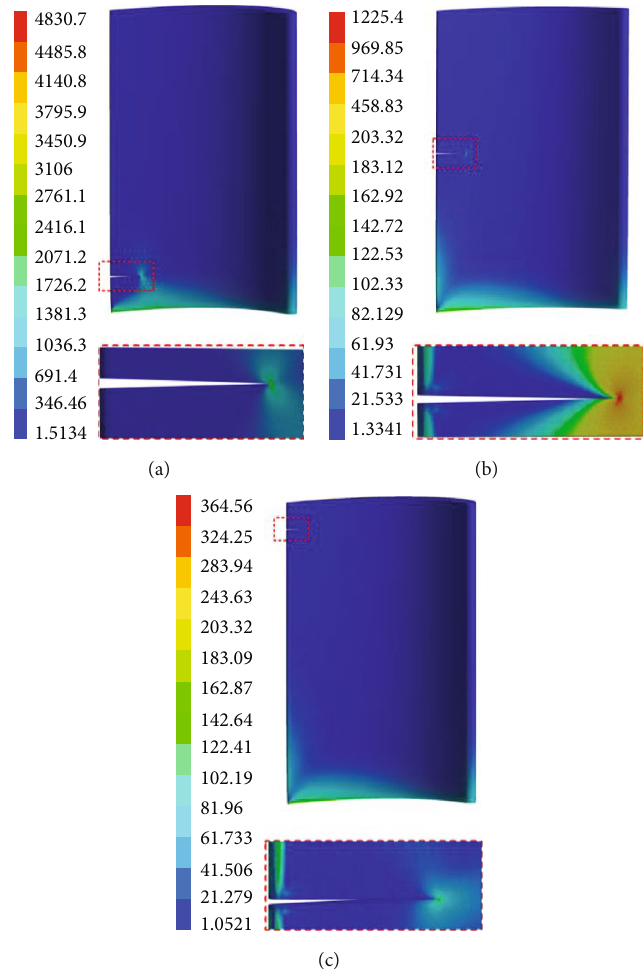
Figure 15: The stress distributions of blades with through-thickness cracks. (a) 0 : 1 H . (b) 0 : 5 H . (c) 0 : 9 H . Blade cross section